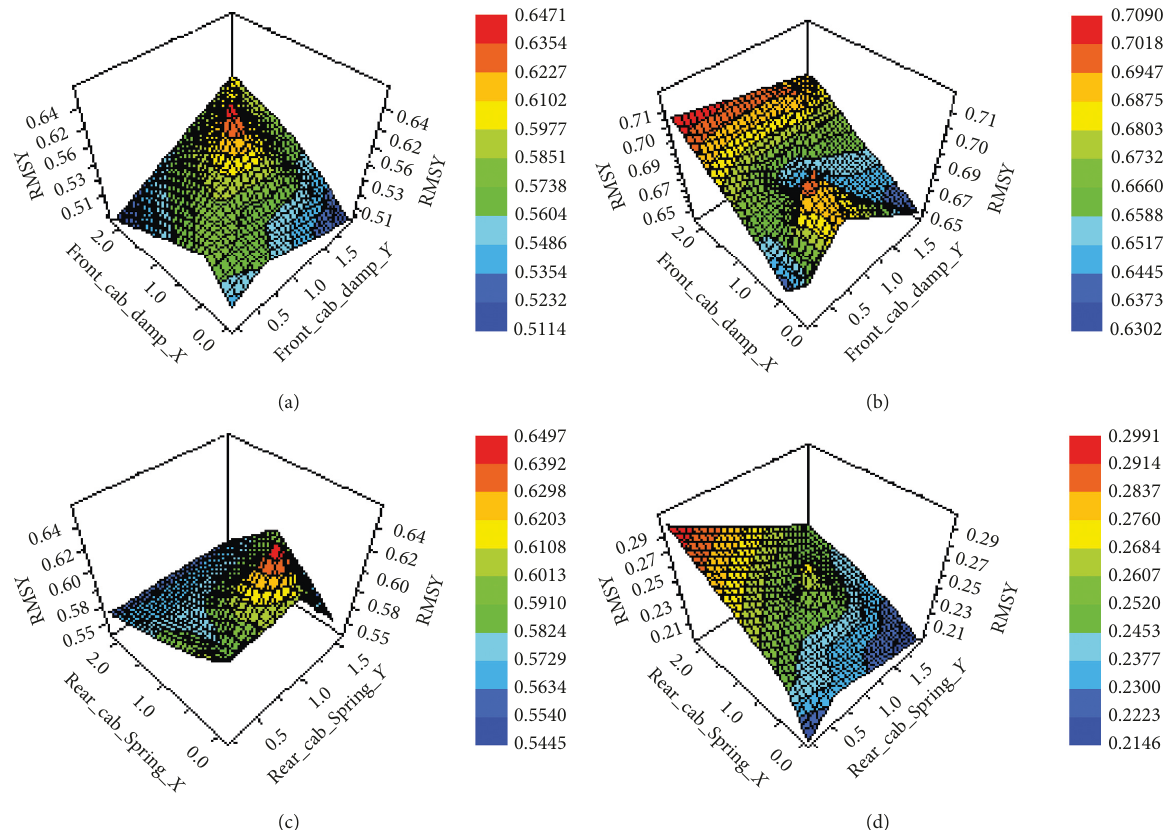
Figure 8: Response surface model of partial cab mounting parameters to steering wheel vibration, which included (a) effect of front suspension damping of cab on y direction vibration, (b) effect of front suspension damping of cab on x direction vibration, (c) effect of rear suspension spring damping of cab on x direction vibration, and (d) effect of rear spring damping of cab on z direction vibration.